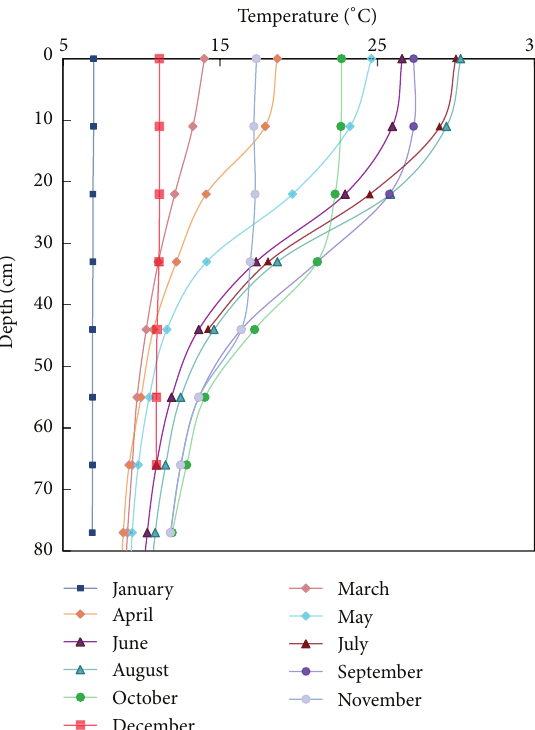
Figure 5: Schematics of temperature distribution.